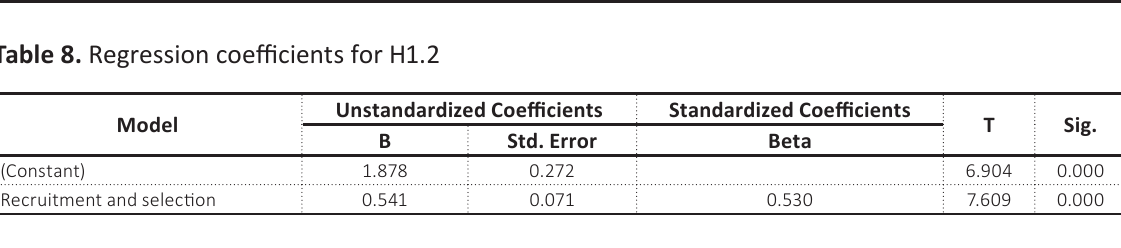
Table 9. Model summary for H1.3